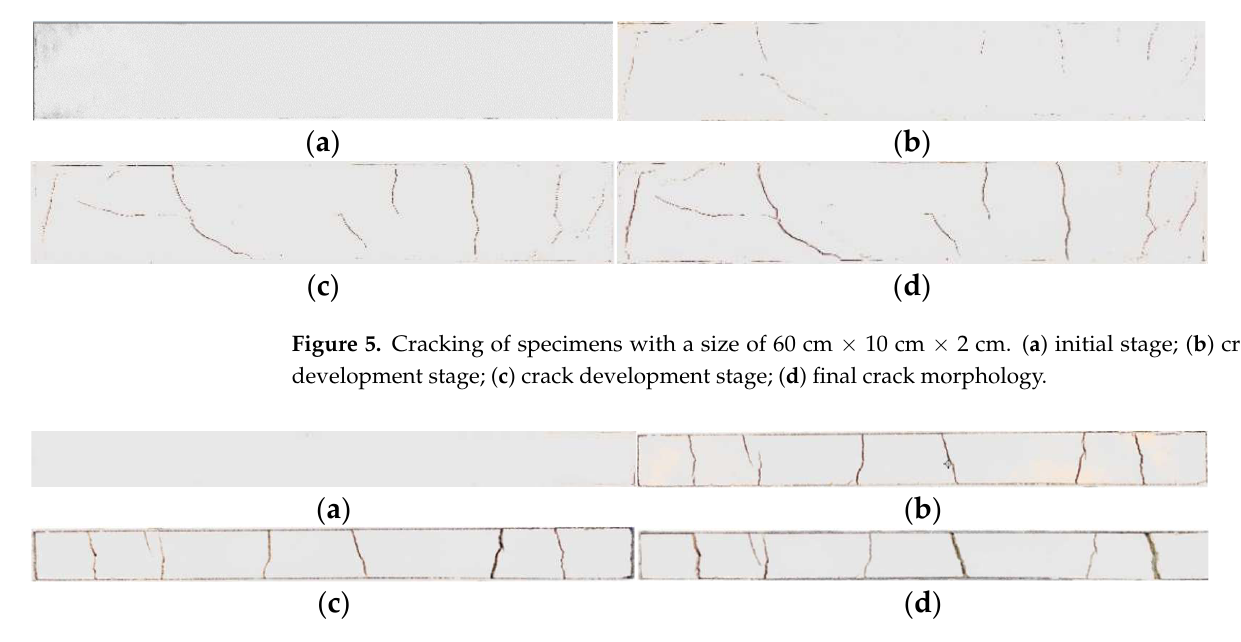
Figure 6. Cracking of specimens with a size of 60 cm × 5 cm × 2 cm. ( a ) initial stage; ( b ) crack development stage; ( c ) crack development stage; ( d ) final crack morphology.